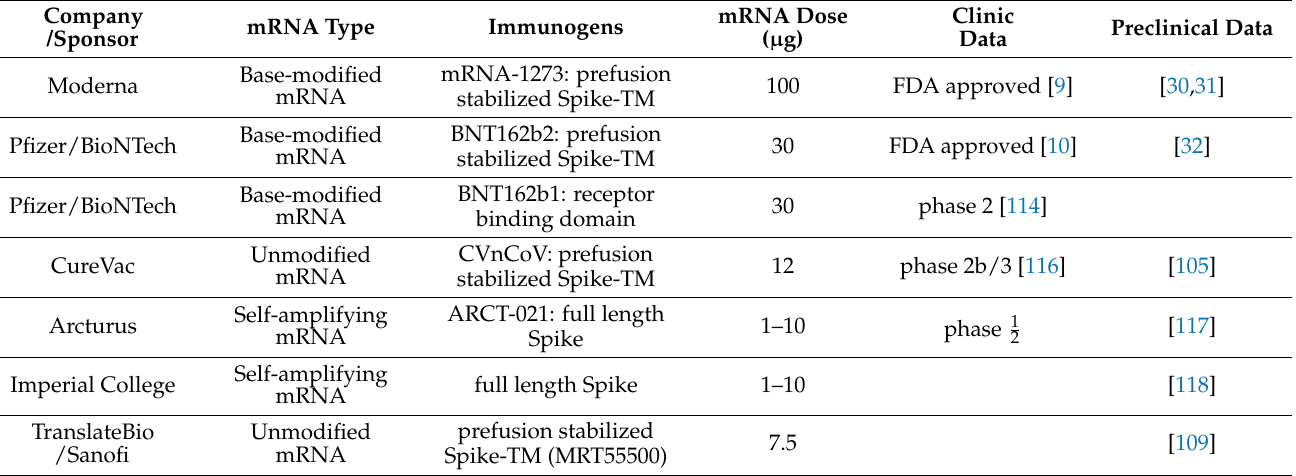
Table 1. SARS-CoV-2 mRNA vaccines in lipid nanoparticle